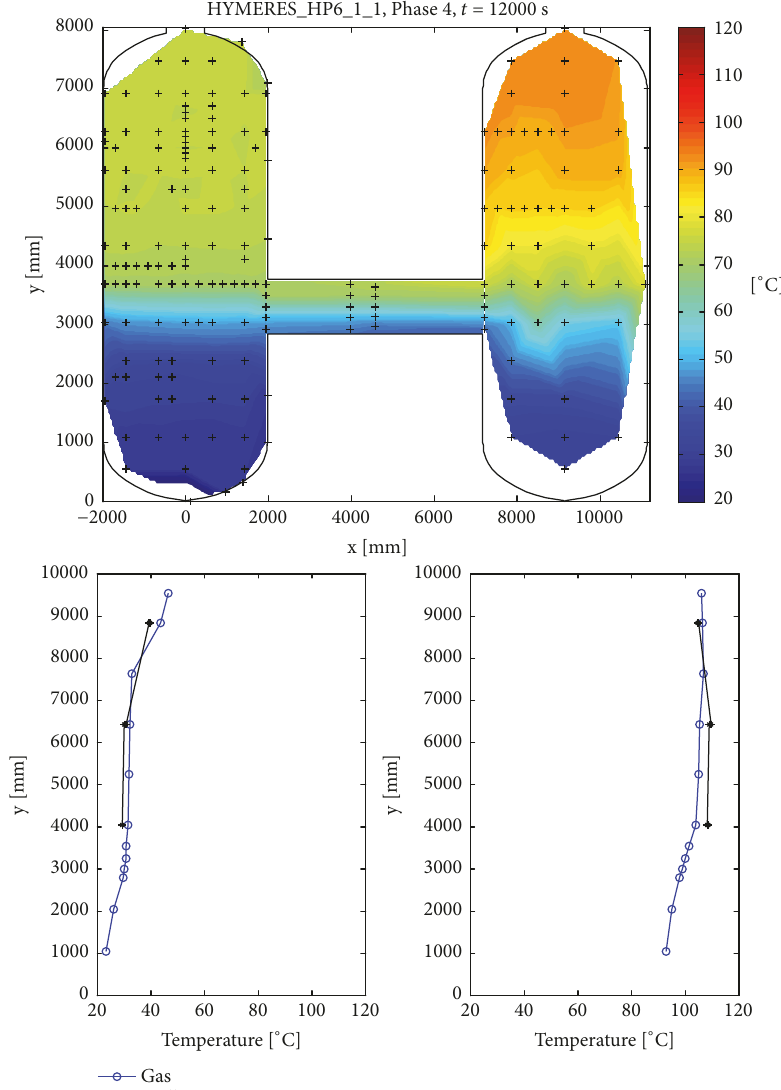
Figure 9: Temperature maps for Vessels 1 and 2 as well as gas and wall temperatures in Vessels 3 and 4 for experiment HP6 1 at 𝑡 = 1200 s .